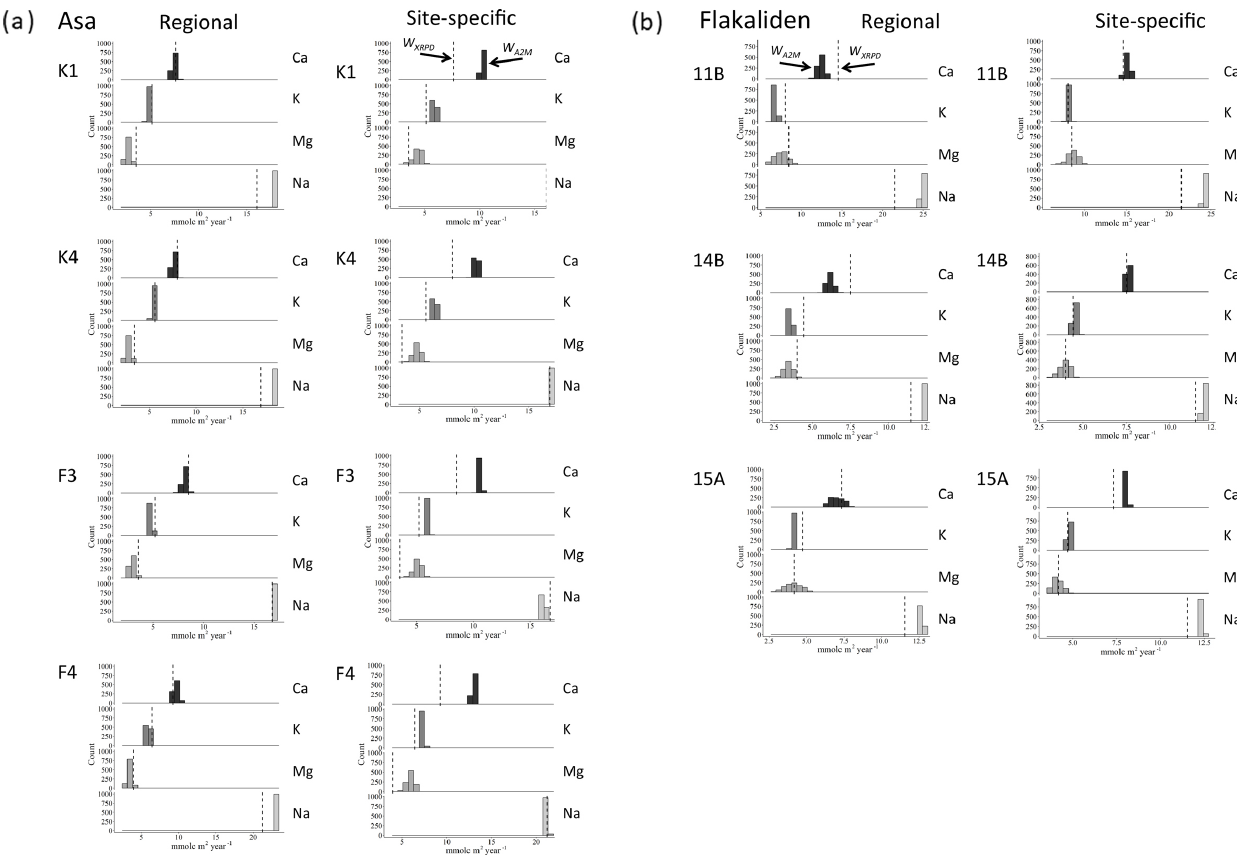
Figure 2. Comparison of PROFILE weathering rates of base cations (mmol c m − 2 yr − 1 ) at Asa (a) and Flakaliden (b) sites in the 0–50cm horizon based on XRPD mineralogy (vertical dashed lines) with PROFILE weathering rates based on 1000 random regional A2M mineralo- gies versus 1000 random site-specific A2M mineralogies. Data presented are from four different soil profiles per site. Regional graph for soil profile 10B at Flakaliden is missing since A2M did not calculate 1000 solutions for soil layer 20–30, due to a “nonpositive solution”.